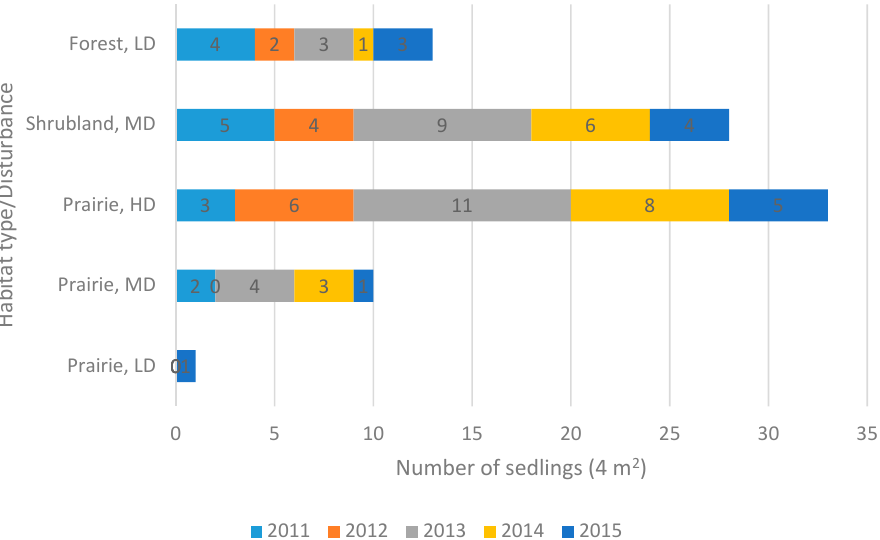
Figure 6. Number of seedlings of Anemone patens in habitats with varying levels of disturbance. Prairie: LD—low disturbance (Battlefords Provincial Park), MD—moderate disturbance (Crocus Prairie Conservation Area), HD—high disturbance (Redberry Lake Biosphere Reserve); Shrubland: MD—medium disturbance (Cranberry Flats Conservation Area); Forest: LD—low disturbance (Prince Albert National Park).